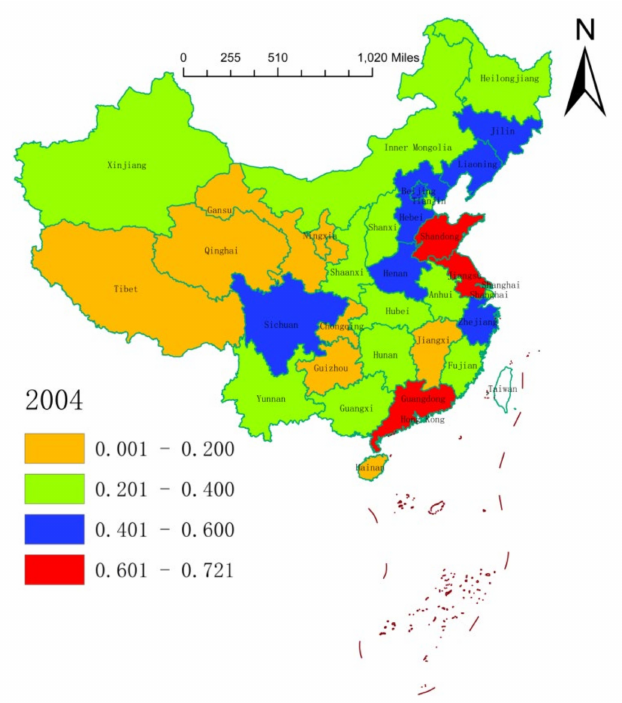
Figure 1. Spatial distribution of health resource agglomeration capacities in China in